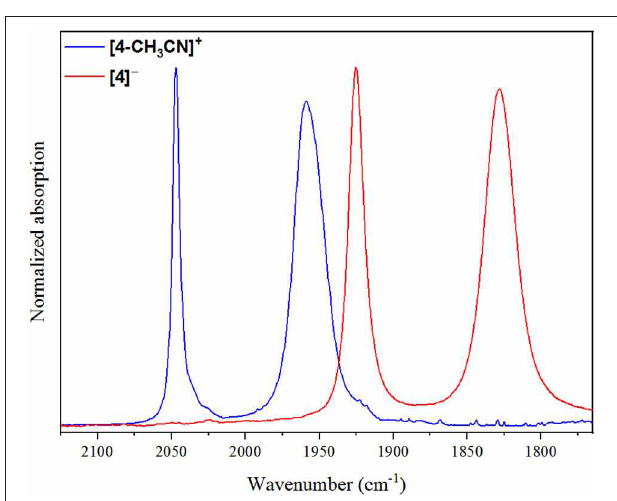
FIGURE 4 | IR-SEC spectra recorded on [3-CH 3 CN] + at the resting potential (blue), upon one-electron reduction (green) and upon two-electron reduction (red).